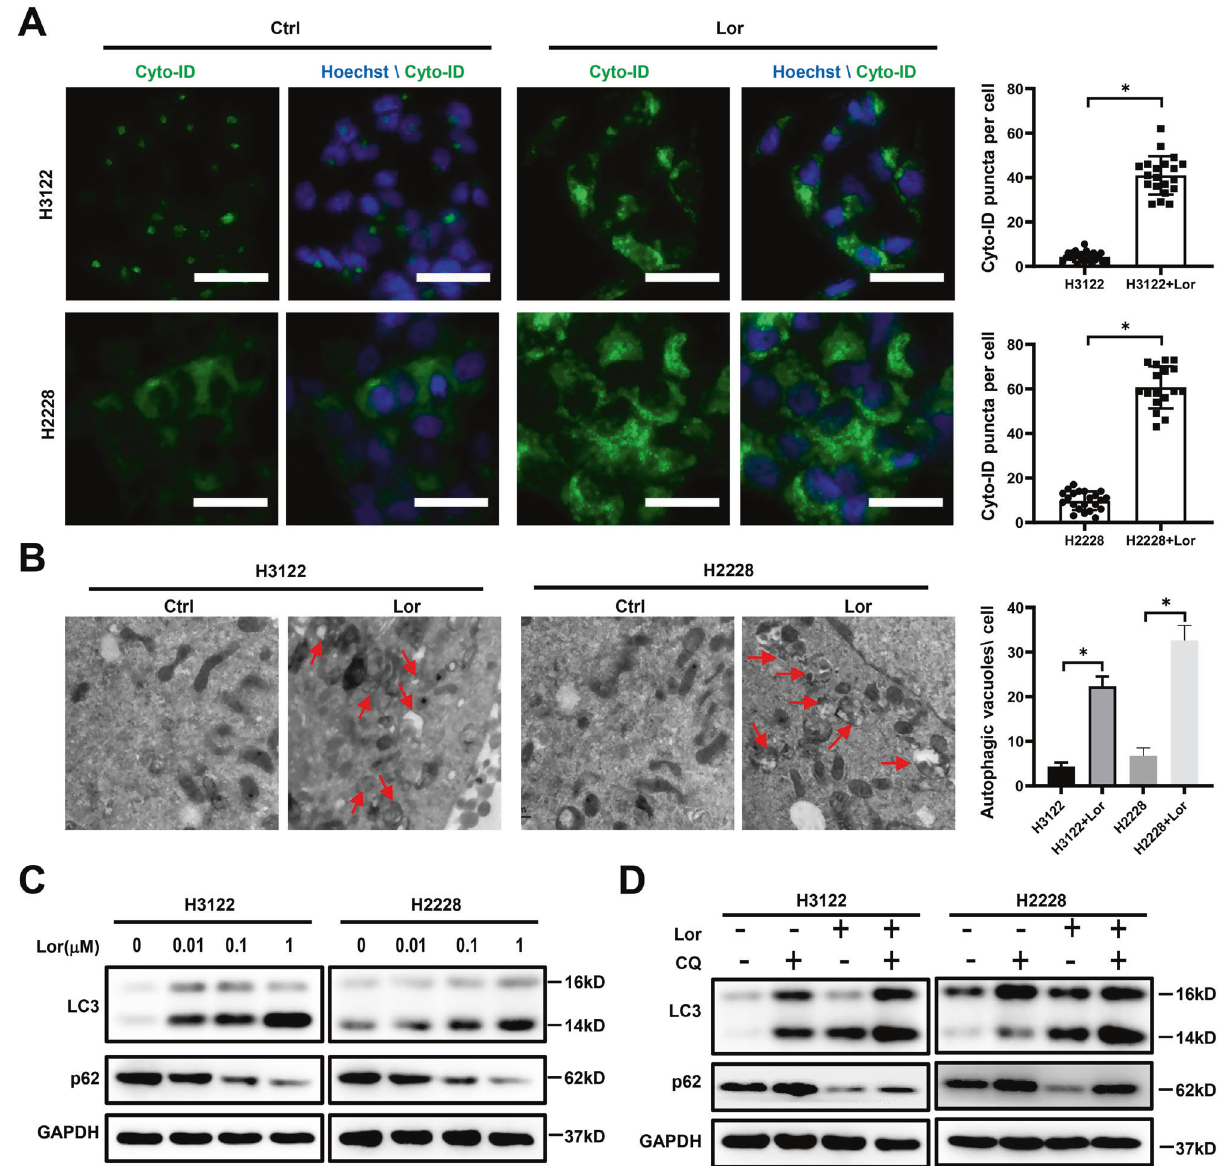
Fig. 2 Lorlatinib induced autophagy in ALK-positive lung cancer cells. A Fluorescence photographs were shown the autophagosomes of H3122 and H2228 cells which were treated with lorlatinib (10 nM) for 48 h. Scale bar is 40 μ m. B Transition electron microscopic images of cells treated with or without lorlatinib for 48 h. More autophagic vacuoles (AVs) were observed in the lorlatinib-treated group than in the control group. C H3122 and H2228 cells were treated with the indicated concentrations of lorlatinib for 48 h. And after treatment, western blot analysis was performed to measure the protein expression levels. GAPDH was included as a loading control. D H3122 and H2228 incubated with lorlatinib (10 nM) for 48 h, with or without treatment with CQ (10 μ M) were analyzed for autophagy fl ux by western blot analysis. Ctrl control, Lor lorlatinib, CQ chloroquine. * P <